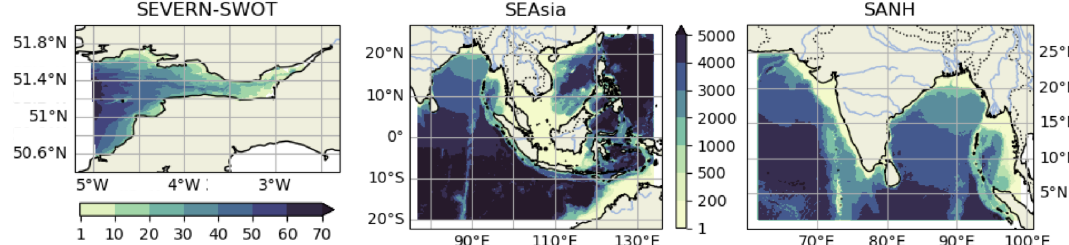
Figure 2. Bathymetry (m) from the Severn Estuary, South-East Asia and South Asia worked example